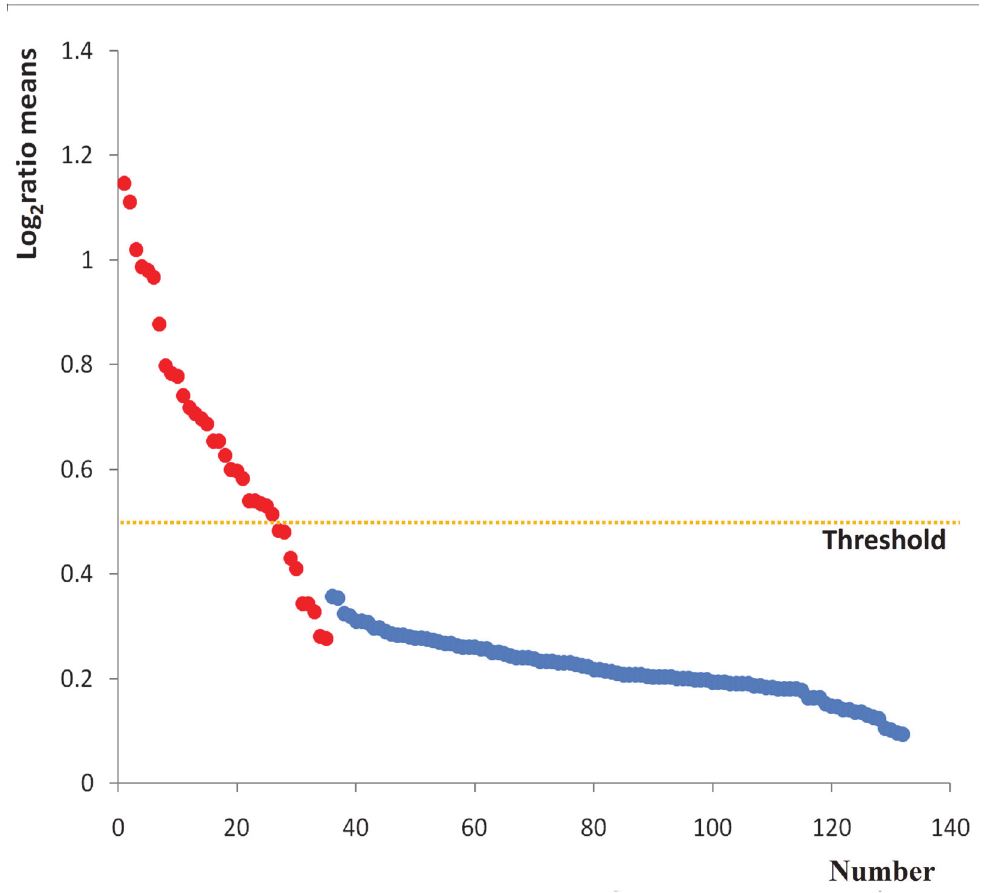
Fig 2. Log2 ratio means of peaks and gene annotation. Log2 ratio means: all probe average of peak area of three NTD samples, red dot represents the area of low methylation NTDs vs control, blue dot represents of high methylation NTDs vs control. The threshold line is the cutoff value, as the log2 ratio means values = 0.5. The numbers on the horizontal axis indicate the sorting number of genes. We did the sorting according to the numerical value of log2 ratio means. The sorting number of related genes showed as S1 Fig.